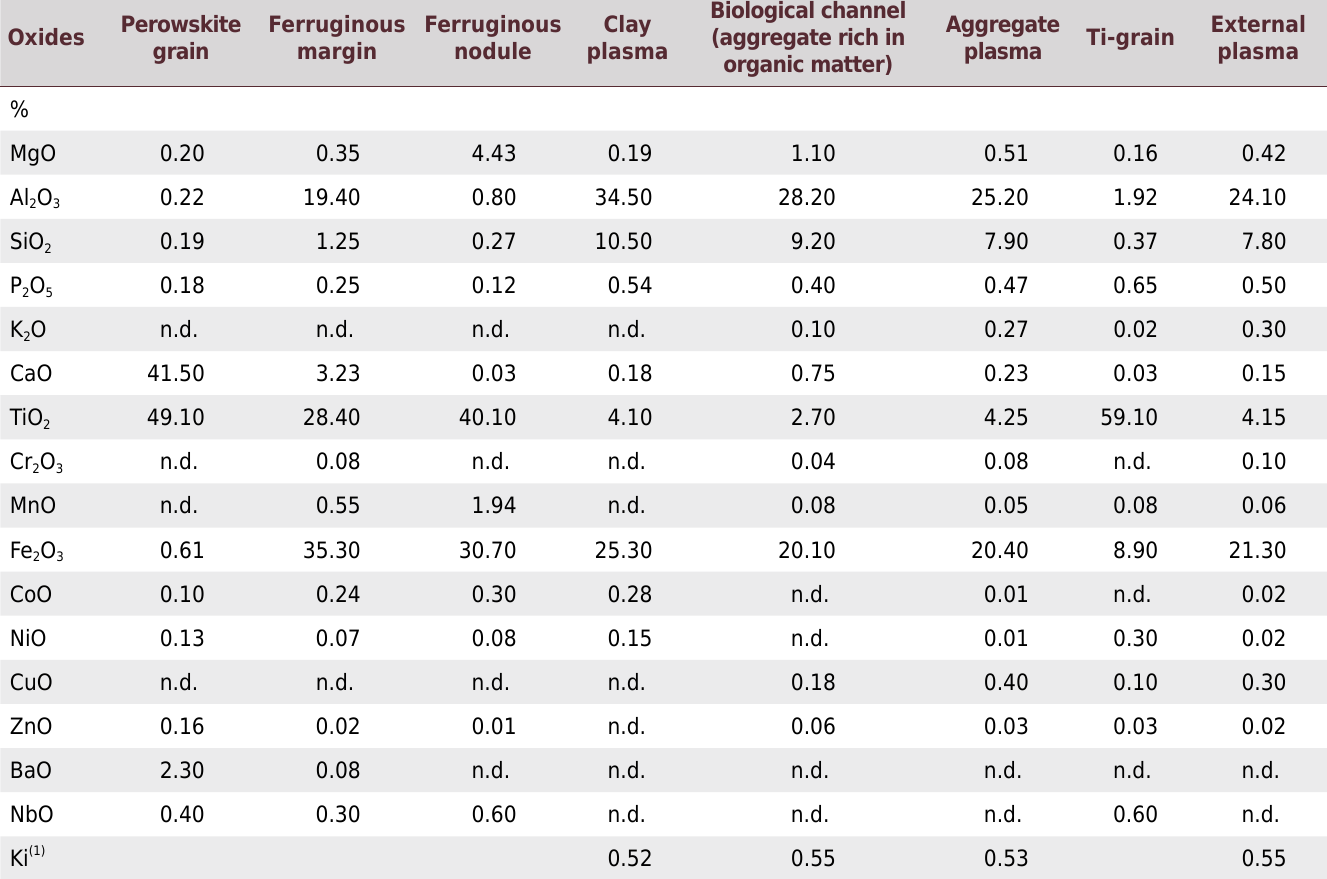
Aggregate External Ti-grain plasma plasma